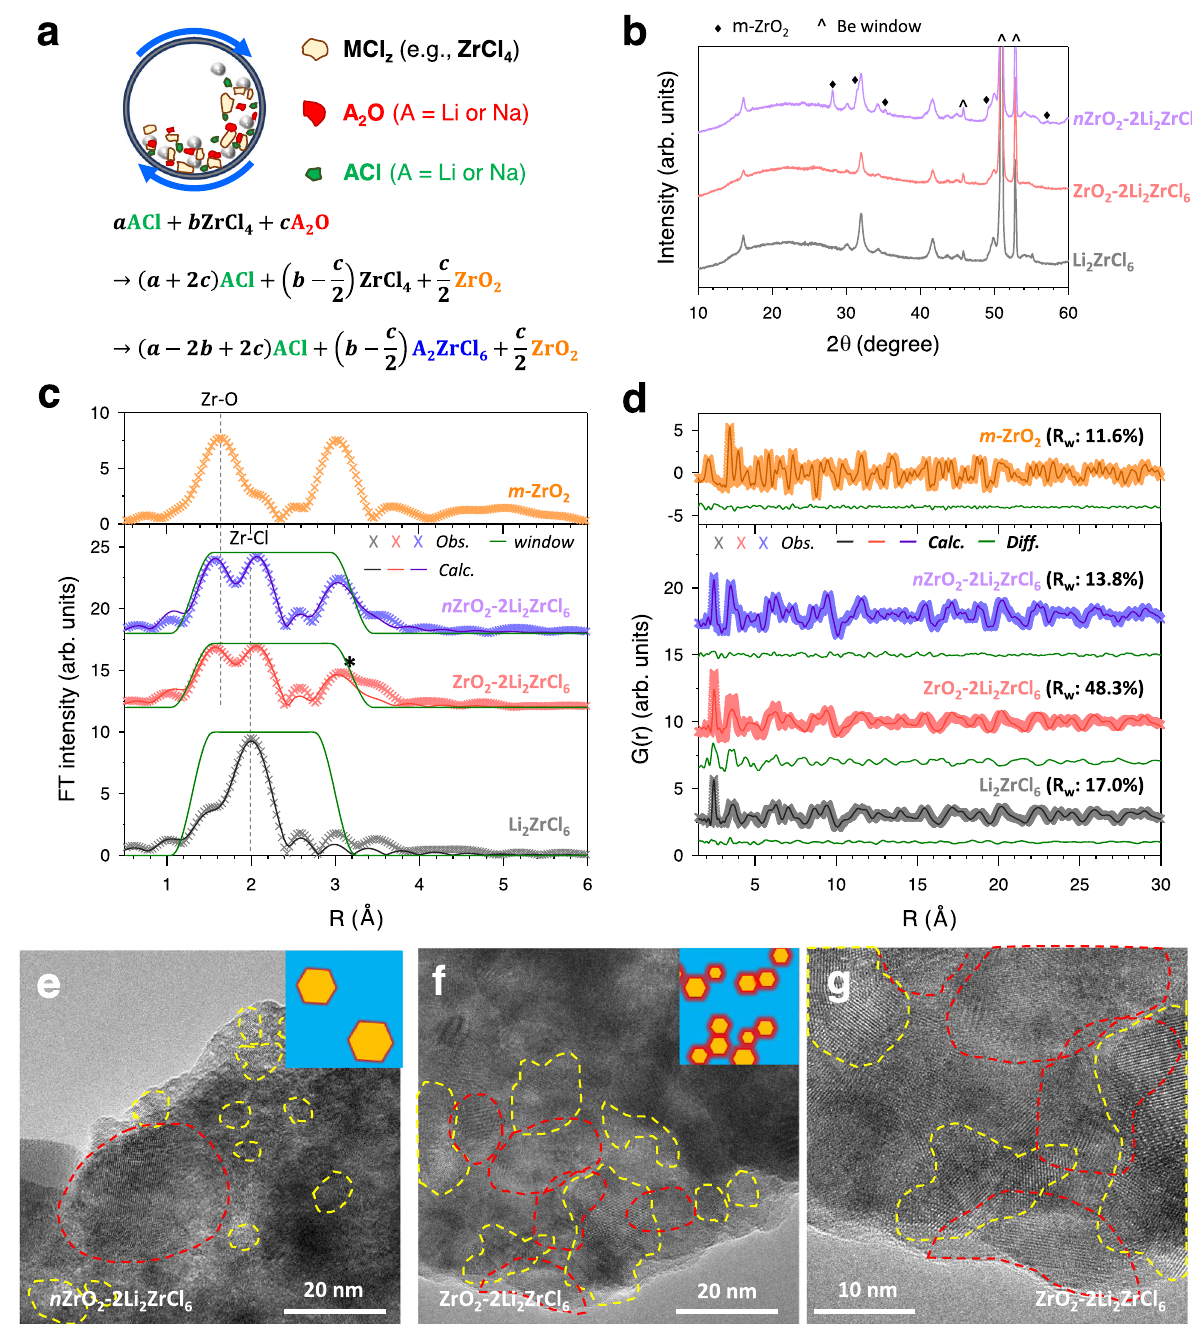
Fig.1|SynthesisandcharacterizationofHNSEs(ZrO 2 − 2Li 2 ZrCl 6 ).a Schematicof theone-potmechanochemicalsynthesisofZrO 2 (-ACl)-A 2 ZrCl 6 (A=LiorNa)HNSEs. b – d XRDpatterns( b ),coordination-number-re fi nedZrK-edgeEXAFS fi ttingcurves ( c ), and PDF G(r) with best- fi t ( d ) for Li 2 ZrCl 6 , ZrO 2 -2Li 2 ZrCl 6 , and nZrO 2 -2Li 2 ZrCl 6 . e – g Cryo-HRTEM images of nZrO 2 -2Li 2 ZrCl 6 ( e ) and ZrO 2 -2Li 2 ZrCl 6 at lower